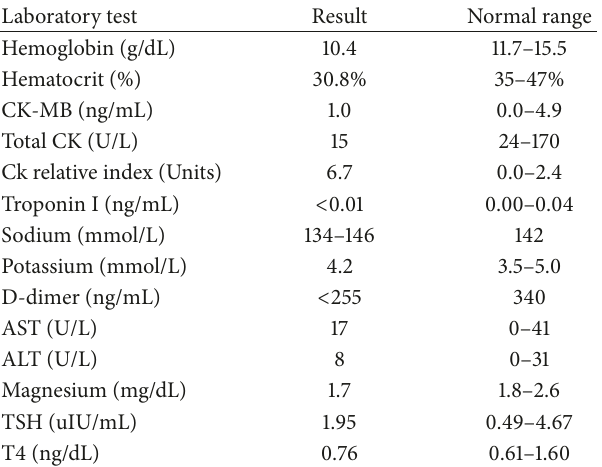
Table 1: Laboratory